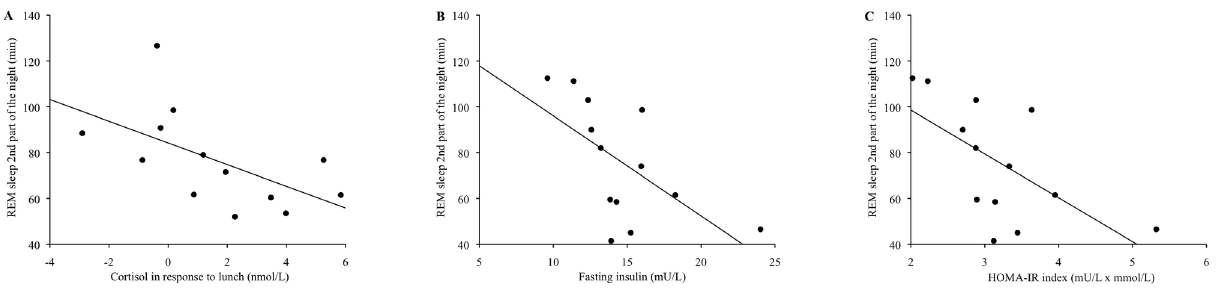
Figure 3. Relationship between REM sleep during the 2 nd part of the night and cortisol concentrations in response to lunch (nmol/L) during phase delay. R 2 =0.334, P<0.05, n=13 (A). Relationship between REM sleep during the 2 nd part of the night and fasting insulin concentrations (mU/L) during phase delay. R 2 =0.374, P<0.05, n=13 (B). Relationship between REM sleep during the 2 nd part of the night and HOMA-IR index (mU/L x mmol/L) during phase delay. R 2 =0.382, P<0.05, n=13 (C). doi: